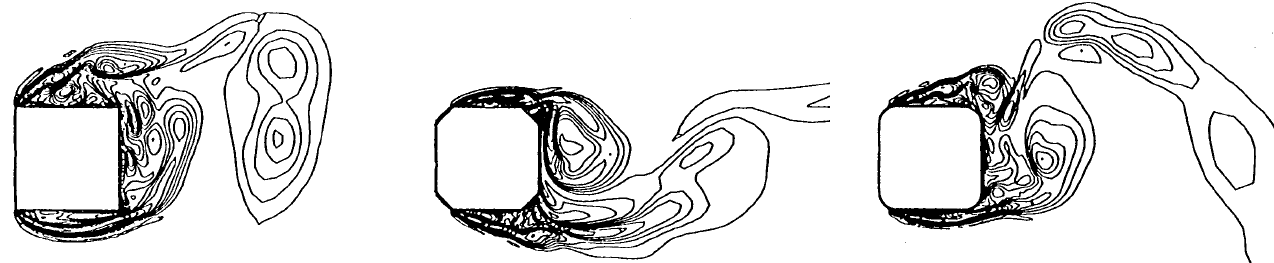
Figure 4. Instantaneous vorticity contours around a sharp corner square cylinder ( Left ), chamfered corners cylinder ( Middle ) and rounded corners cylinder ( Right ); figure reprinted from Tamura and Miyagi [33] Copyright (1998), with permission from Elsevier.